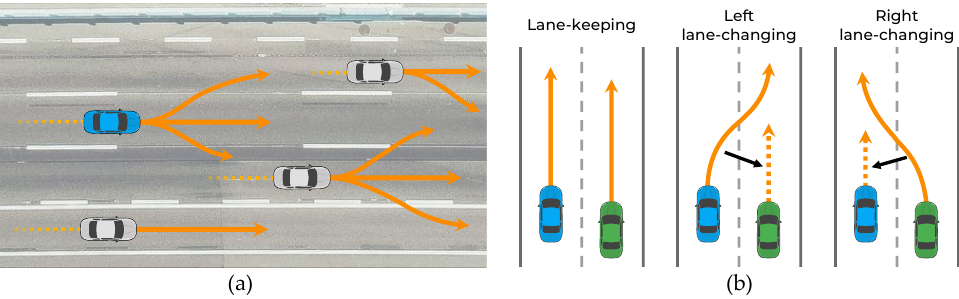
Figure 1. Illustration demonstrating the necessity of awareness of interactions among multimodal maneuvers: ( a ) Vehicles with multimodal maneuvers; ( b ) vehicle movement affected by maneuver of surrounding